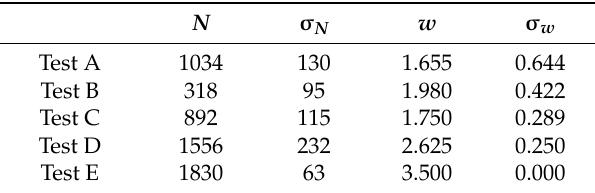
Table 2. Data from compression